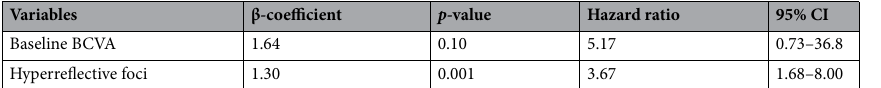
Variables β-coefficient p -value